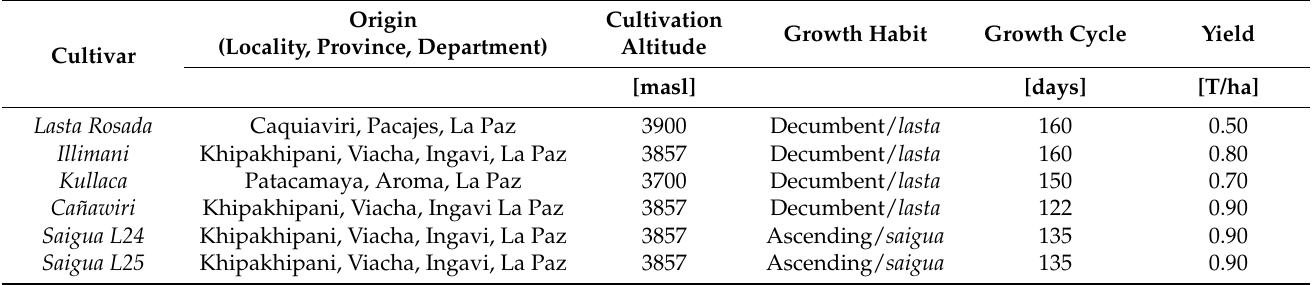
Table 1. Characteristics and location of canihua ( Chenopodium pallidicaule) cultivars used in the study † .